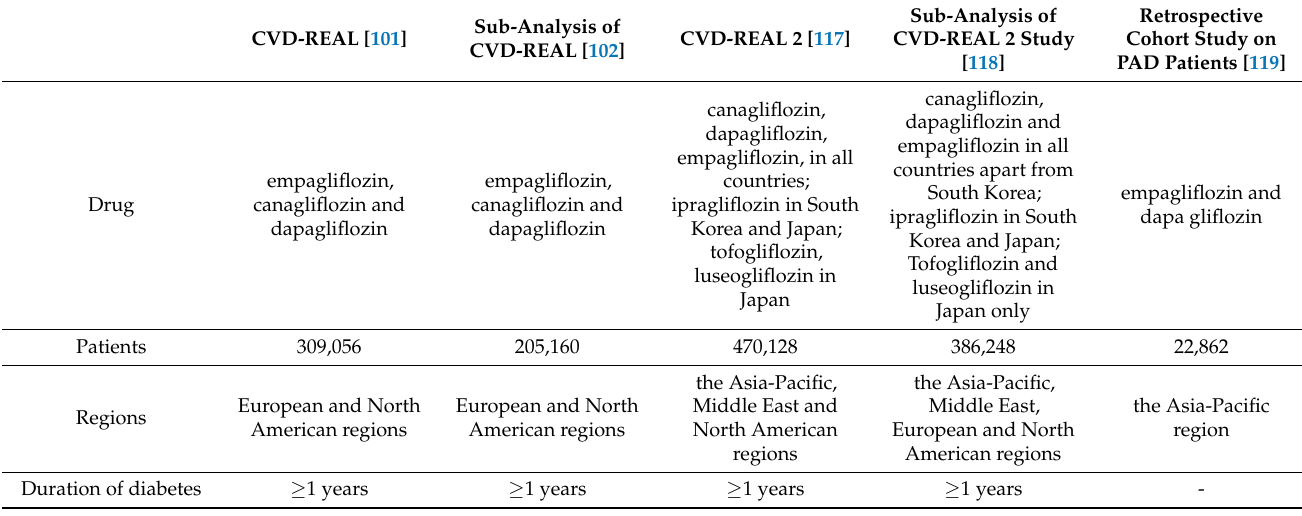
Table 3. Reported real world evidence of SGLT2 inhibitors for